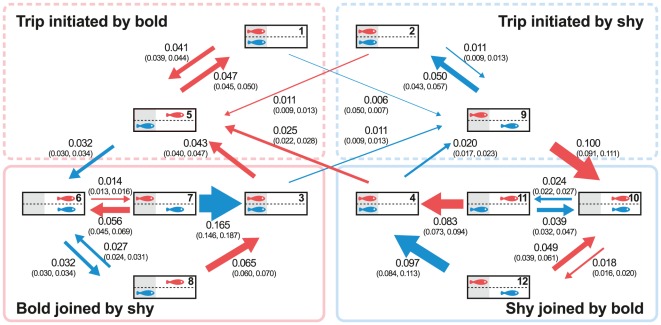
Transition intensities from the Markov Chain model.Transition intensities (best estimates and 95% CI) for leaving and returning to cover, estimated for the bold (red) and shy fish (blue) depending on which individual initiated the trip out of cover and whether it was successful in recruiting its partner. The width of each arrow is proportional to the magnitude of the transition intensity. For each state, the area under cover is shaded, while the exposed area is in white; each state is identified with a number at the top-right corner of the “tank".